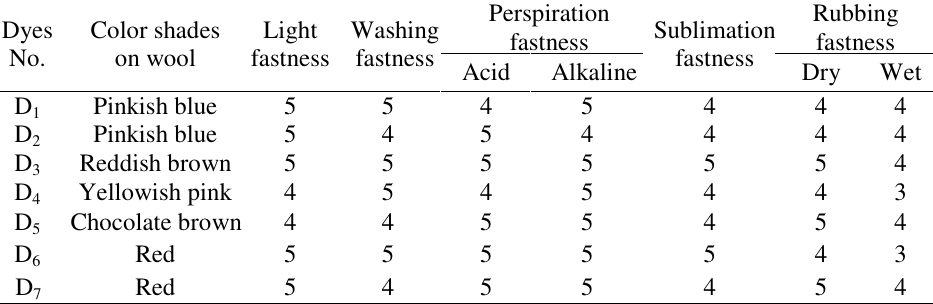
Table 2. Results of acid azo dyeing and various fastness properties of dyes on